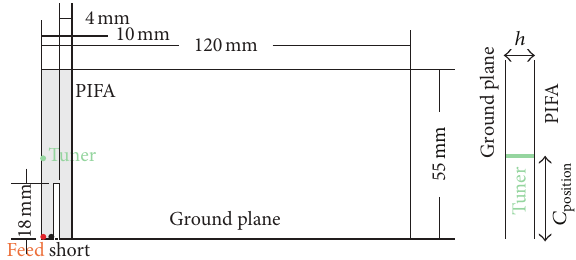
Figure 1: Antenna design used to investigate the impact of 𝐶